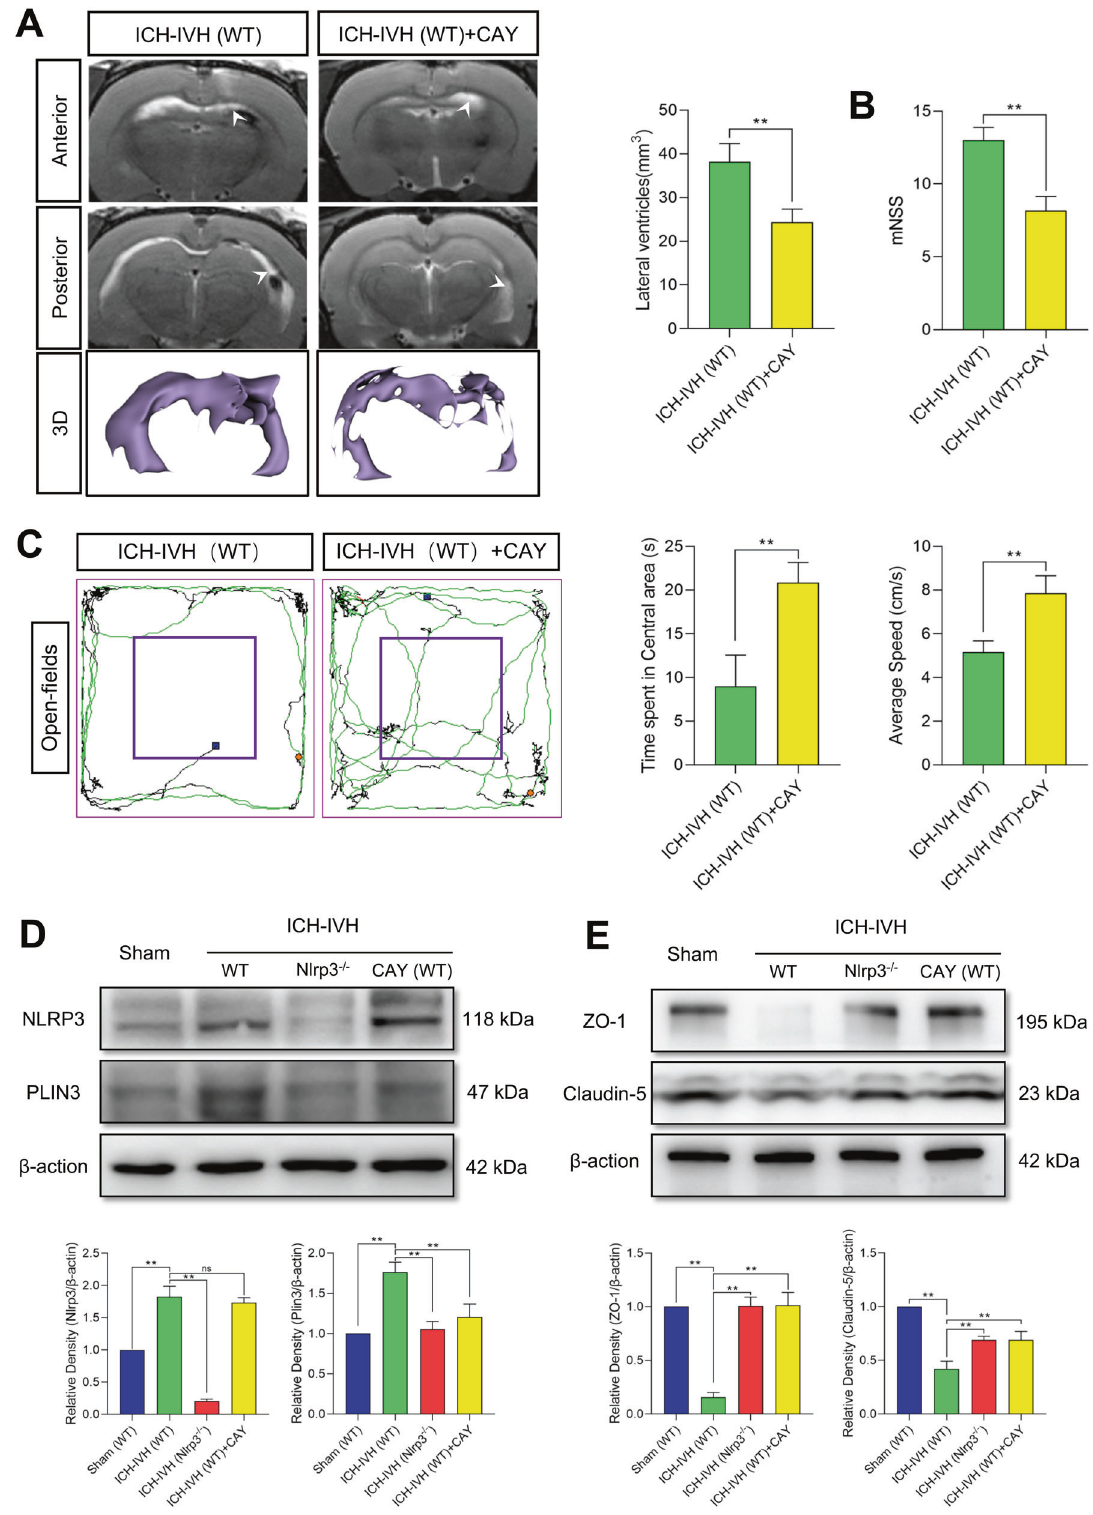
Fig. 6 NLRP3 mediates tight junction dysfunction by altering LD formation. A T2-weighted and 3D reconstruction images showed lateral ventricles and volume analysis results ( n = 3, unpaired t test). B Statistical analysis of the mNSS results ( n = 6, unpaired t test). C Trajectory images and analysis results of the open- fi eld tests with and without CAY10650 treatment after ICH-IVH ( n = 6, unpaired t test). D Western blot detection of NLRP3 and PLIN3 in the choroid plexus and quanti fi ed abundance results ( n = 3, 6 rats per sample, one-way ANOVA). E Western blot images and statistical results showing the expression of the tight-junction-related proteins ZO-1 and claudin-5 in the choroid plexus ( n = 3, 6 rats per sample, one-way ANOVA). The results are expressed as the mean ± SD, ** P <